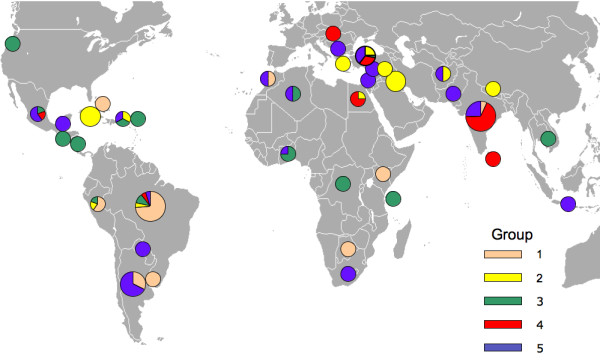
Genotypes of Ricinus communis from nuclear SNPs were best described by five genetic clusters in a worldwide collection of 488 germplasm samples. Group colors correspond to Fig. 1 and circle sizes represent relative number of samples. Samples were only considered in a particular group if they meet a 60% threshold of group assignment. Thus, not all samples were assigned to a group because they shared affiliation with several different groups.